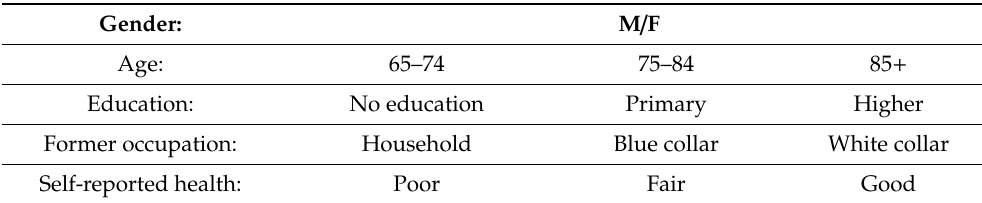
Table A1. Socio-demographic